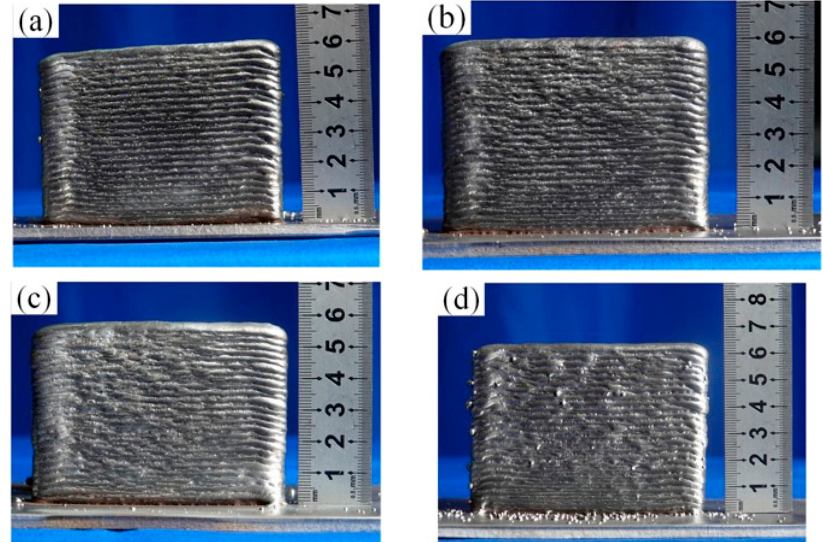
Figure 5. The morphology of four additive manufacturing walls: ( a ) deposited part A, ( b ) deposited part B, ( c ) deposited part C, ( d ) deposited part D.